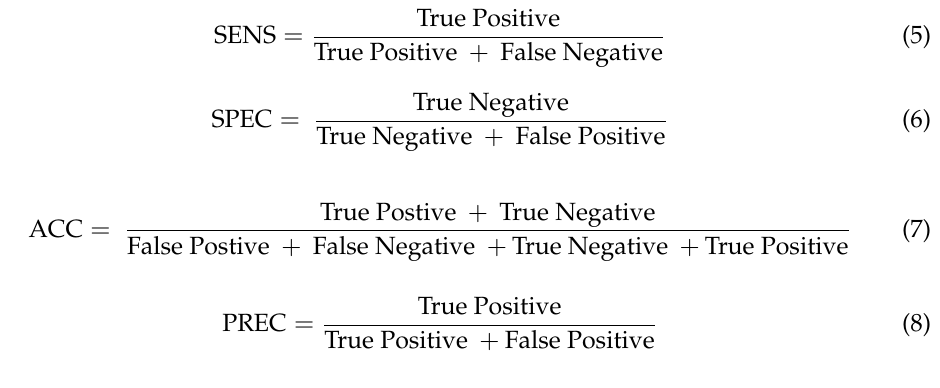
Table 8. Classification of the pessary and standard groups based on different machine learning models. Cross